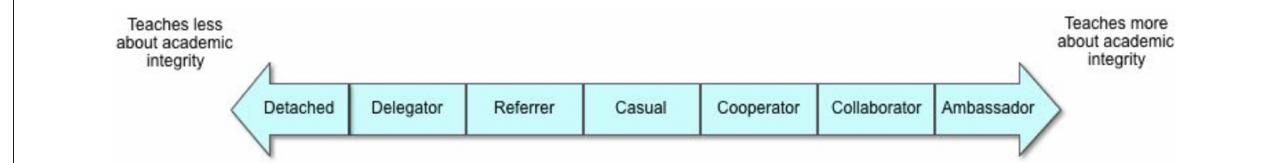
FIGURE 1 | Seven roles professors adopt when teaching about academic